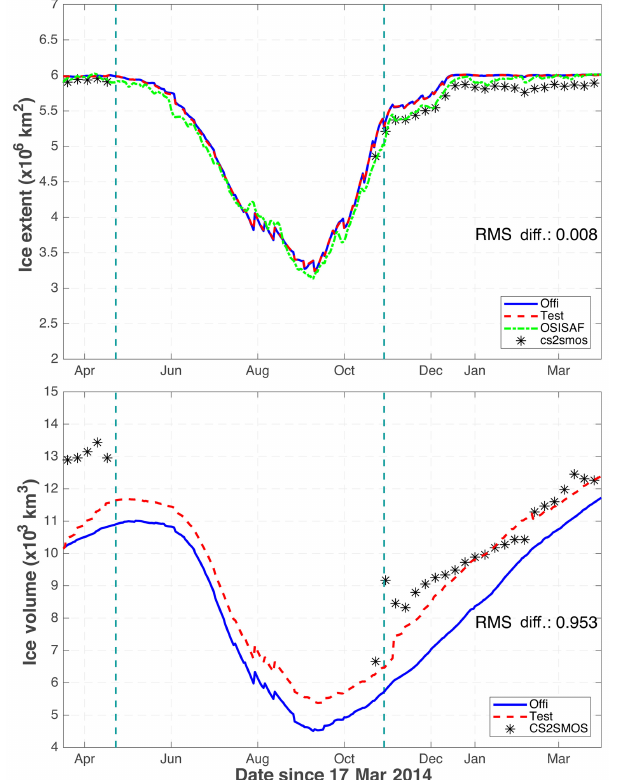
Figure 11. SIE and SIV in the official run (blue) and the test run (red) in the Central Arctic. The black stars are the corresponding weekly SIE (or SIV) estimated from CS2SMOS. The green dashed line is the daily SIE from OSI-SAF. The averaged differences of the two runs (Official–Test) are reported. The vertical cyan dashes delimits the periods when C2SMOS data is assimilated. Figure 12. (a) First three weekly SITs (20–26 October; 27 October–